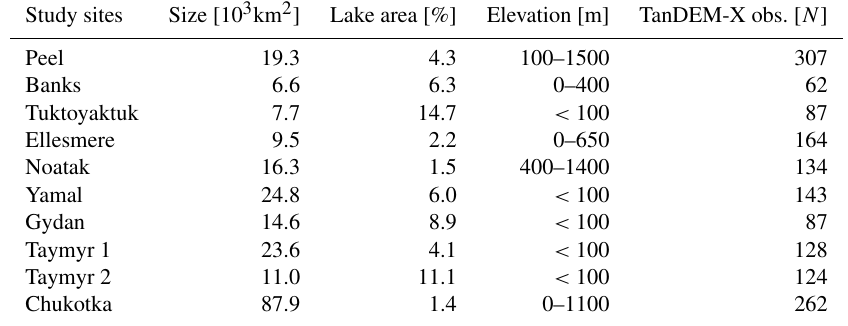
Table 1. Overview of study sites with size, lake area percentage, elevation range, and number of processed TanDEM-X observations. Study